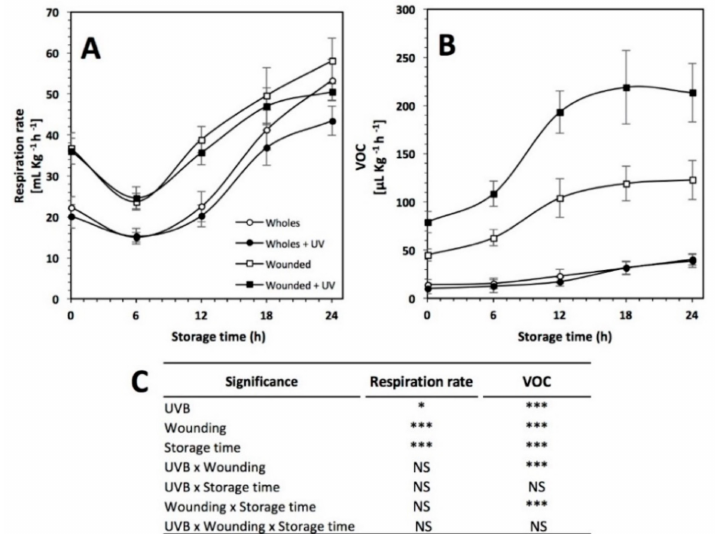
Figure 5. ( A ) Respiration rate and ( B ) volatile organic compounds (VOCs) production in untreated red prickly pear, treated with UVB light (6.4 W · m − 2 ) for 15 min alone, treated with wounding stress alone, and treated with both UVB light and wounding stress during storage time (0, 6, 12, 18, and 24 h) at 16 ◦ C. ( C ) Full factorial analyses of variance showing the main e ff ects and interactions of the variables evaluated. Values represent the mean of five replicates with their standard error bars. Asterisks indicate that main e ff ects and interactions are significantly di ff erent by analyses of variance (ANOVA).